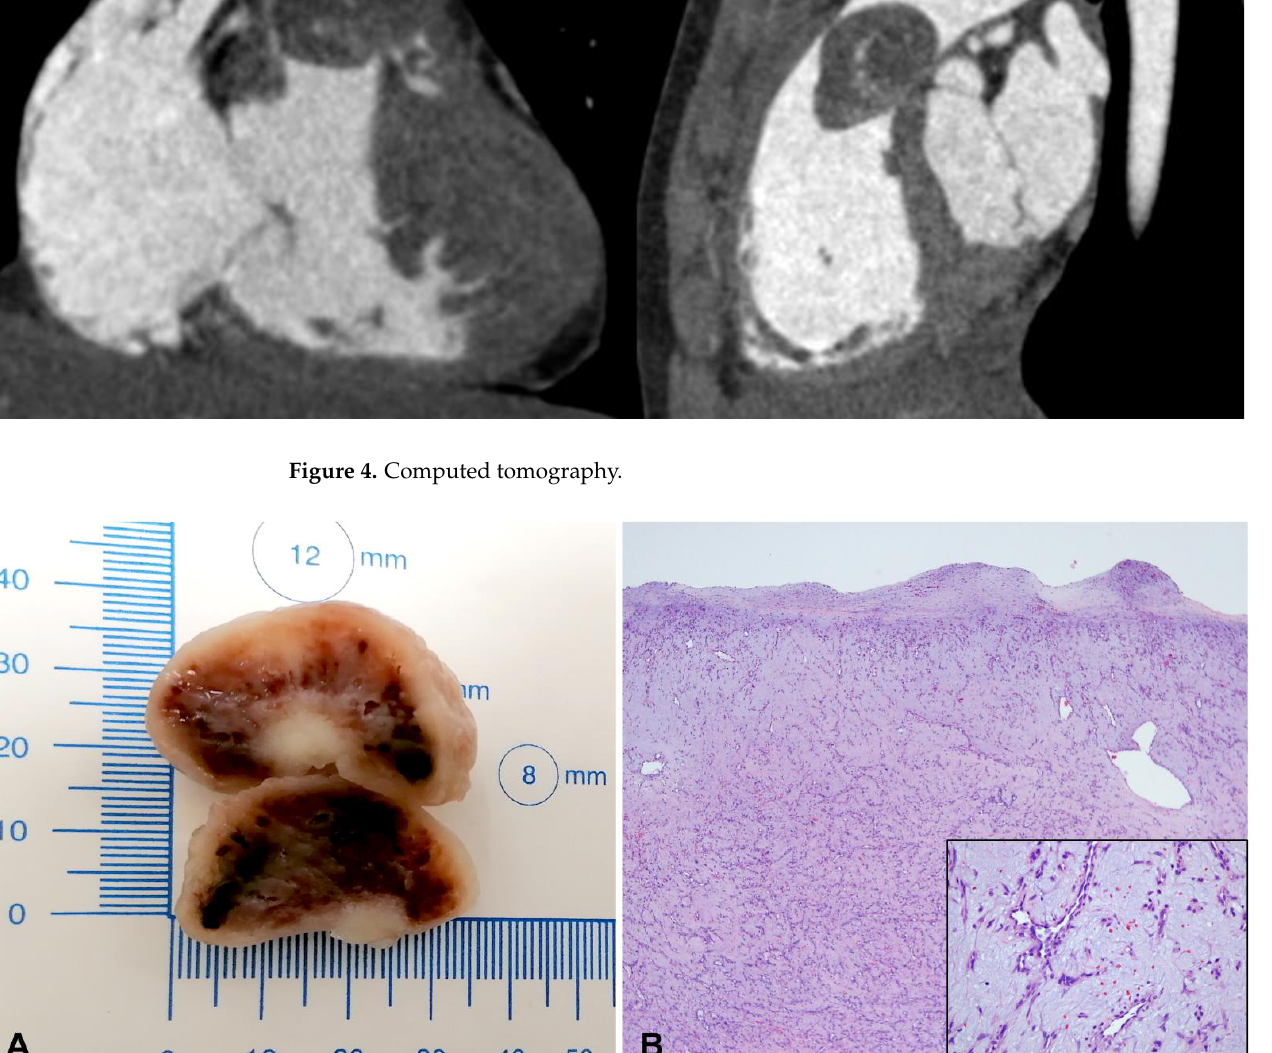
Figure 5. Resected infundibular myxoma ( A ) Section of myxoma biopsy ( B ) Hystological analysis